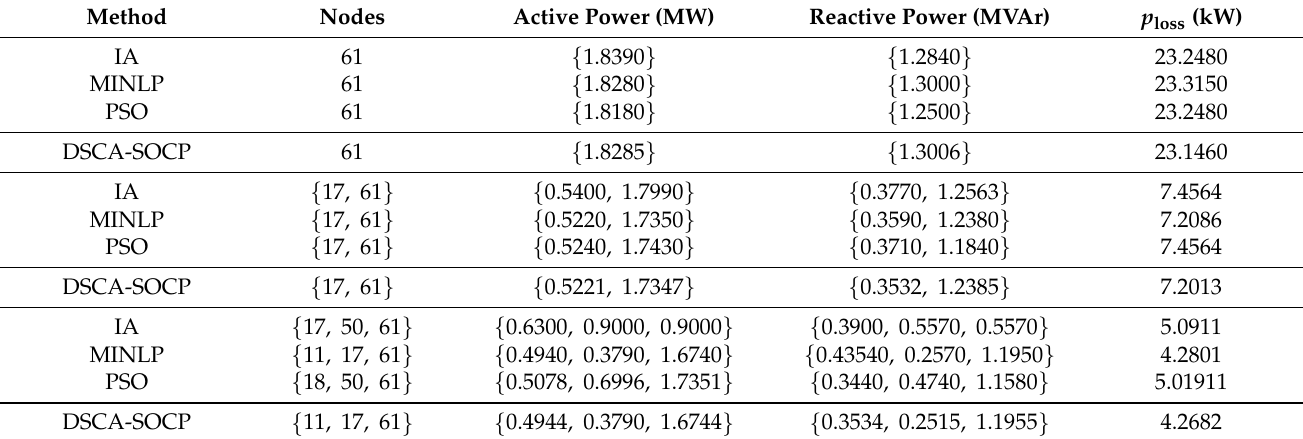
Table 5. Optimal location and sizing of the DGs considering variable power factor capabilities in the 33-node test